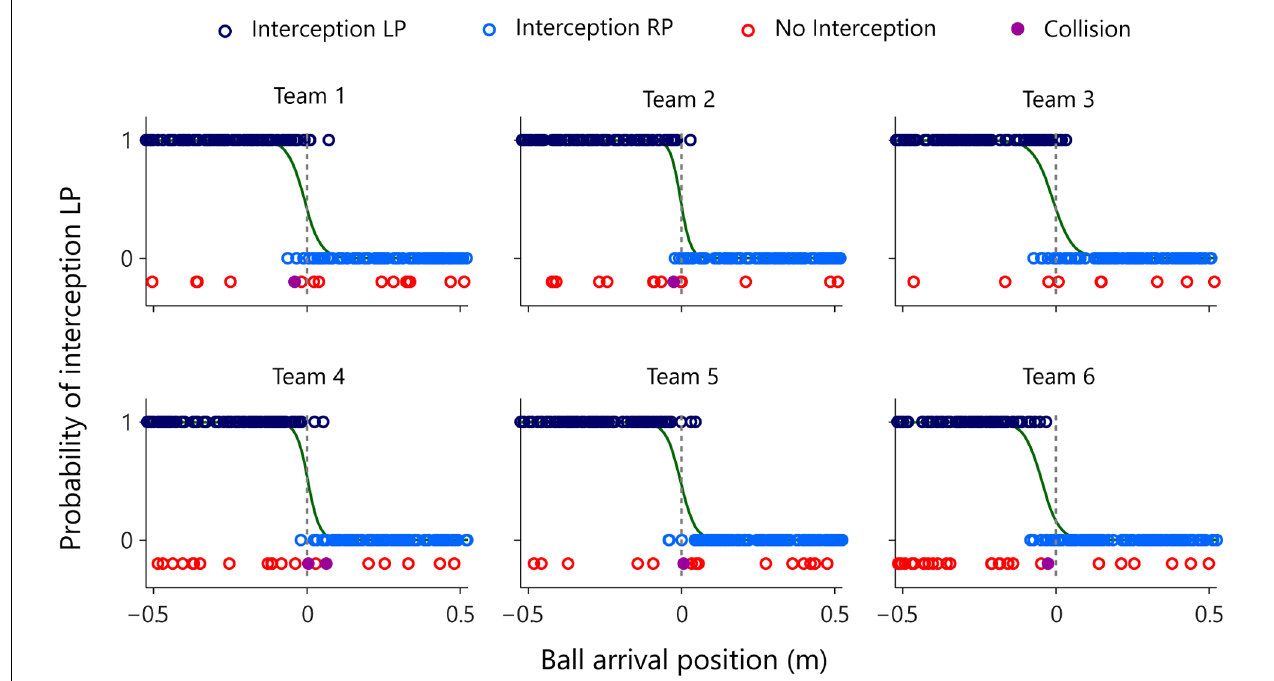
FIGURE 4 | Graphical summary of interception performance as a function of ball arrival position for all six teams separately. Ball arrival positions for each successful trial are indicated by dark blue (LP interception) and light blue (RP interception) circles. Ball arrival positions of unsuccessful trials are indicated by red circles (errors) and purple dots (collisions). The green curves depict the logistic curves representing the probability that LP ( P = 1) or RP ( P = 0) will intercept the ball as a function of ball arrival position. The horizontal dashed gray lines at ball arrival position 0 cm indicate the center of the interception axis.